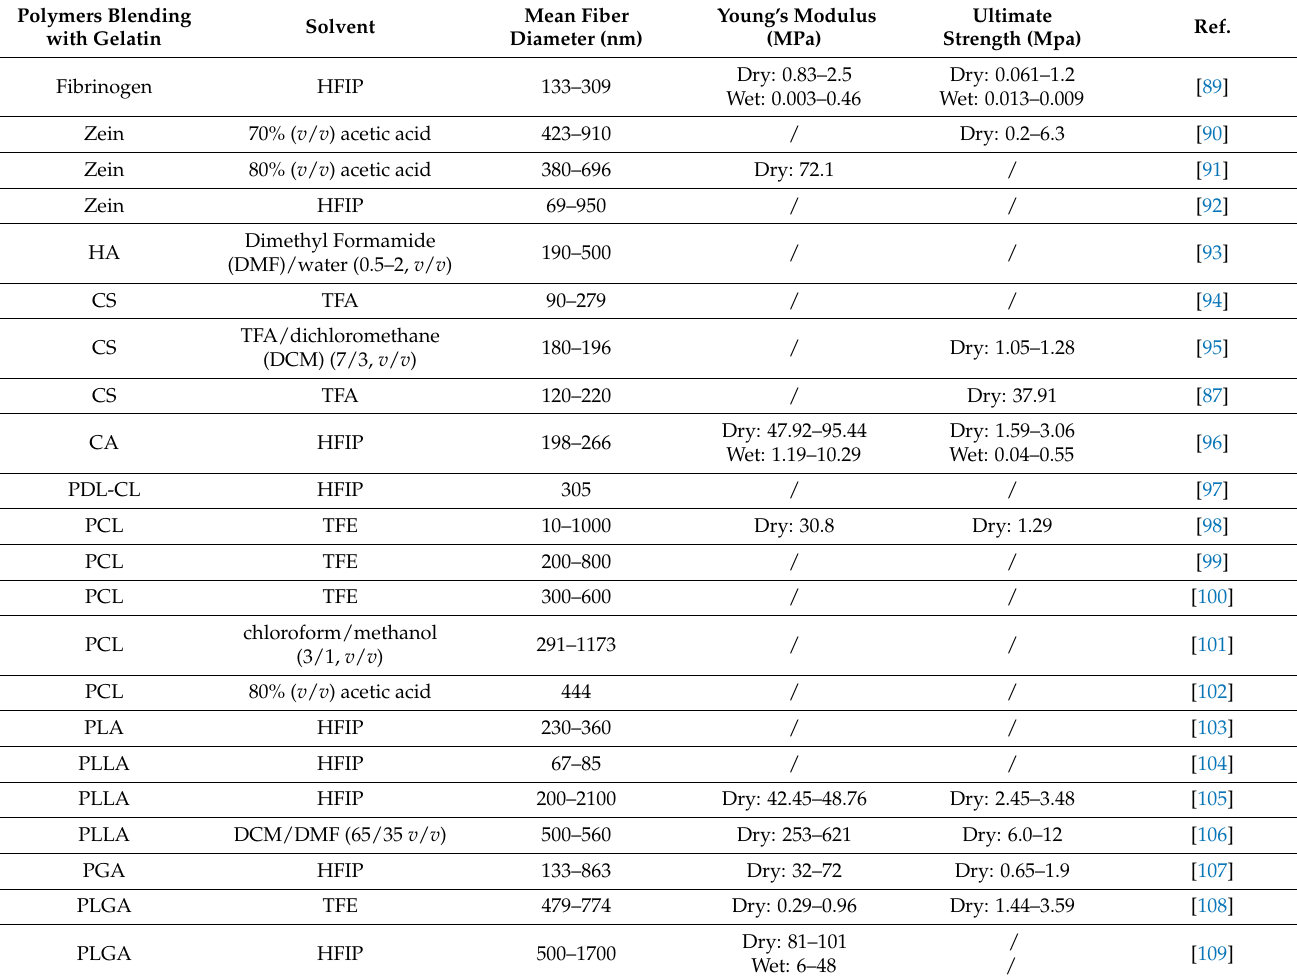
Table 1. Lists of some representative polymers blending with gelatin for electrospinning. Polymers Blending with